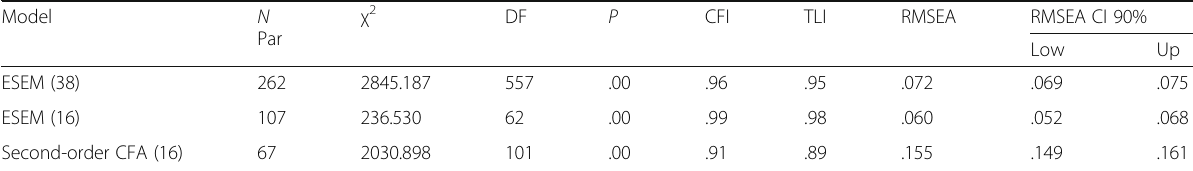
Table 1 Global fit of measurements models